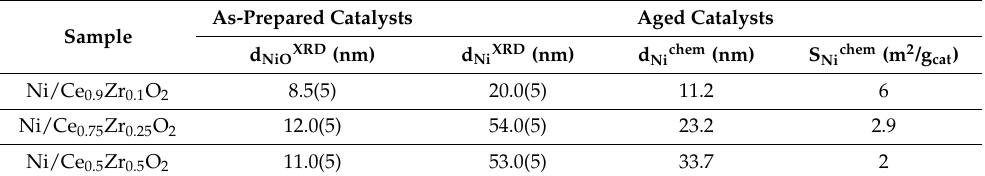
Figure 4. Fragments of XRD patterns fitted using the Rietveld refinement method for Ni/Ce 0.9 Zr 0.1 O 2 ( a , d ), Ni/Ce 0.75 Zr 0.25 O 2 ( b , e ), and Ni/Ce 0.5 Zr 0.5 O 2 ( c , f ) catalysts before ( a – c ) and after ( d – f ) the catalytic reaction. Table 4. Average size characteristics of nickel species in the as-prepared and used Ni/Ce 1 − x Zr x O 2 catalysts according to the XRD and CO chemisorption